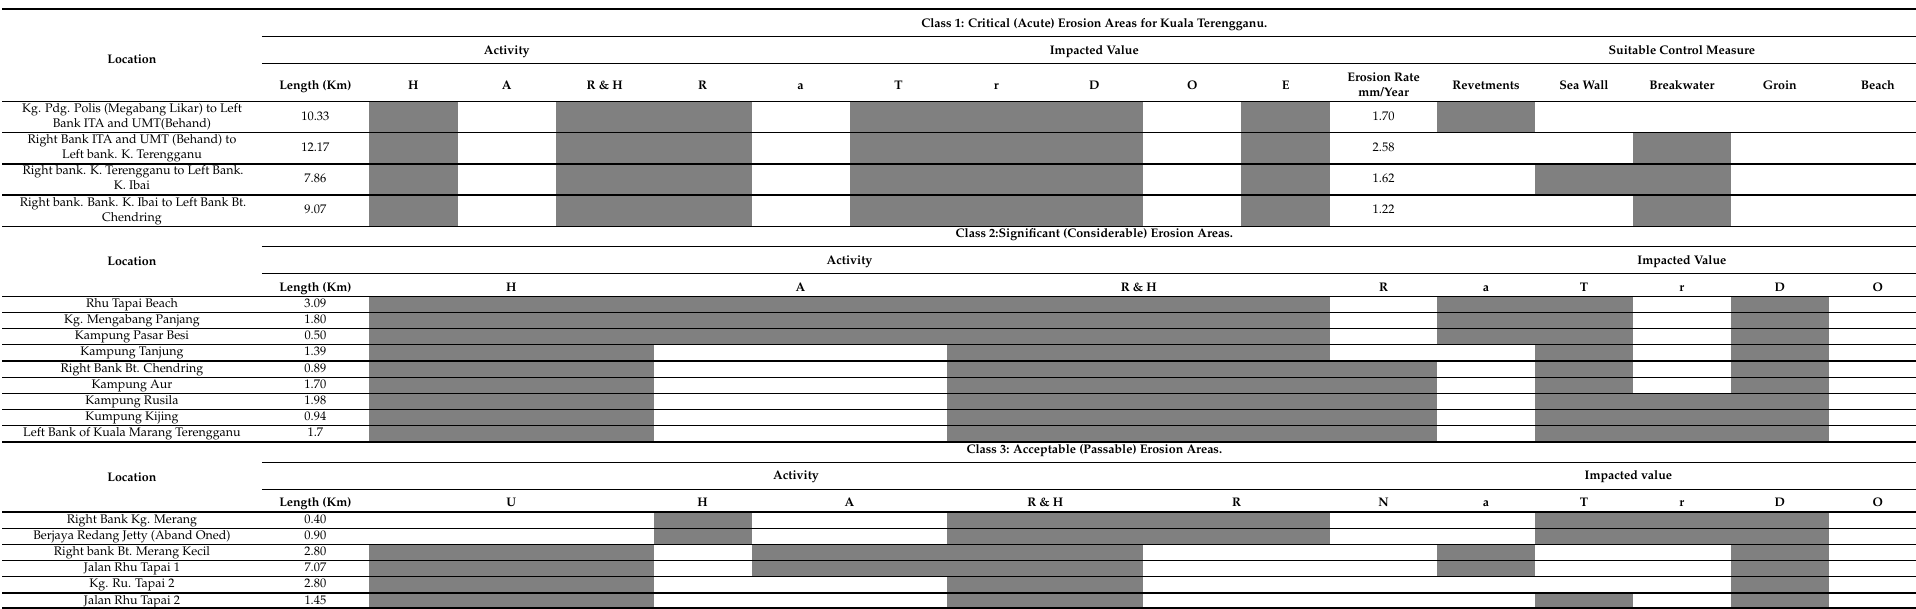
Table 5. Critical, significant and acceptable erosion